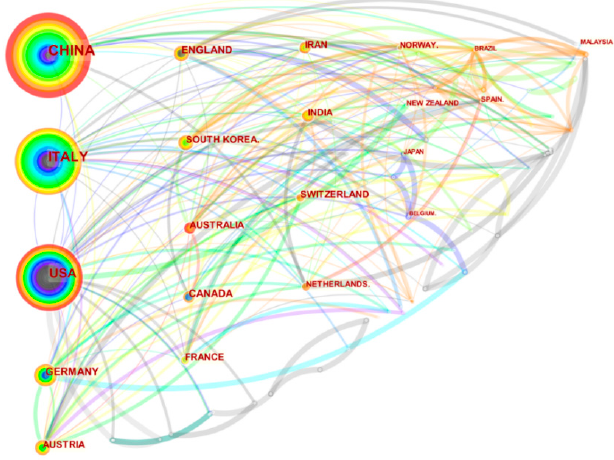
Figure 7. National cooperation network knowledge graph.